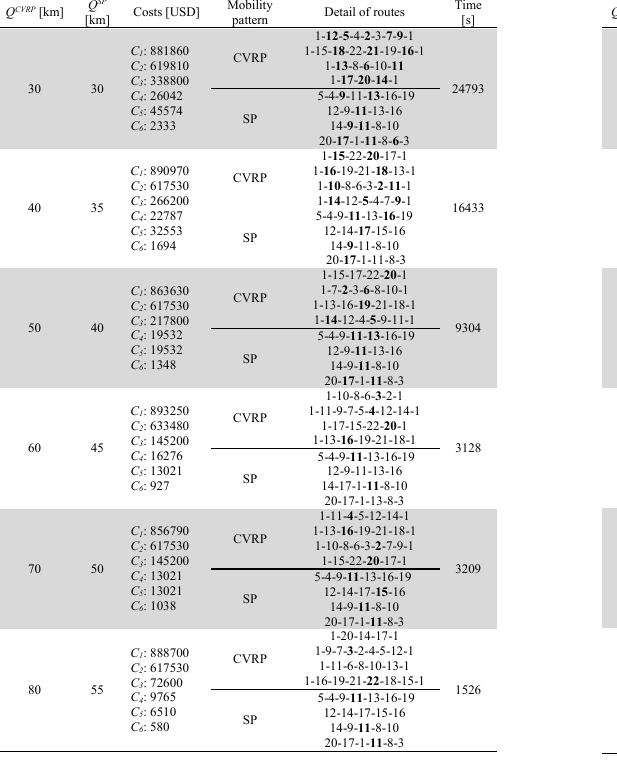
Results for En22k4-IEEE123 with non-linearized mathematical model Q CVRP [km] Q SP [km] Costs [USD]